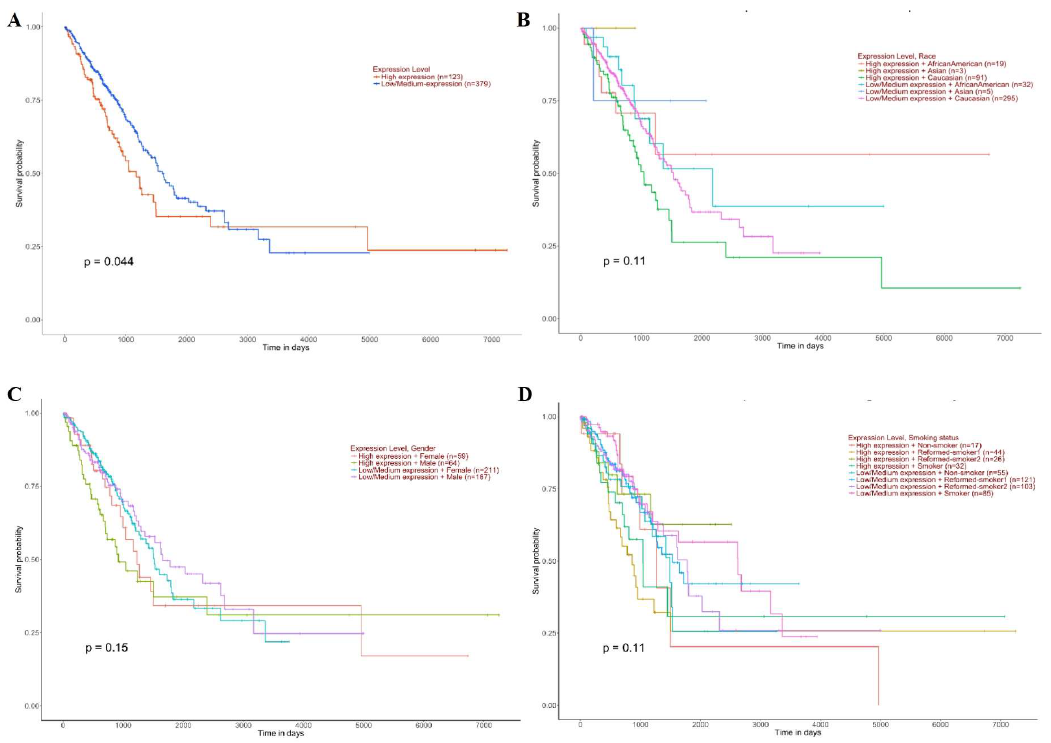
Figure 5. Prognostic roles of SLC3A2 in different subgroups of LUAD patients. ( A ) Sample type; ( B ) Race; ( C ) Gender; ( D ) Smoking habits.